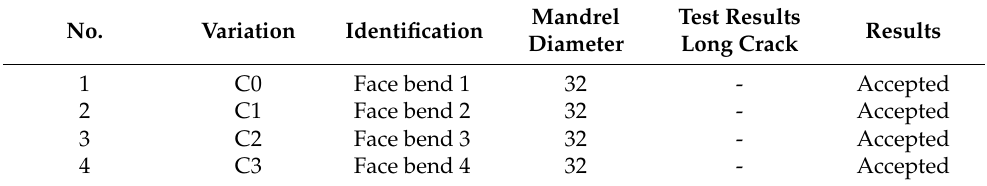
Table 7. Face bend test results of welding specimens on land and in wet-saltwater. No.